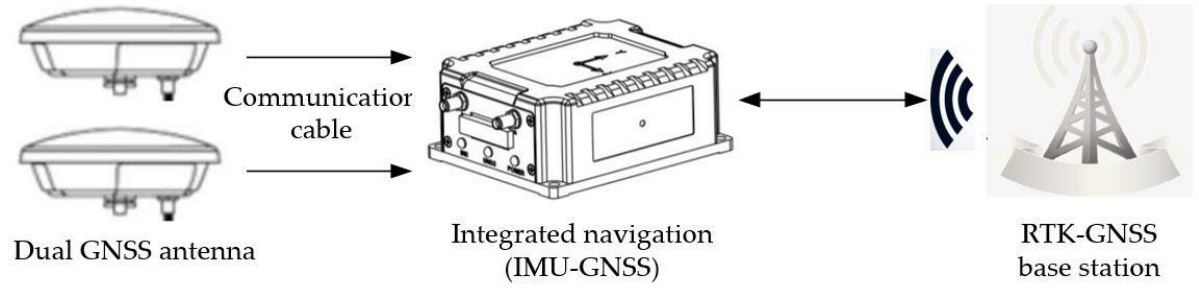
Figure 12. Diagram of the measuring system .